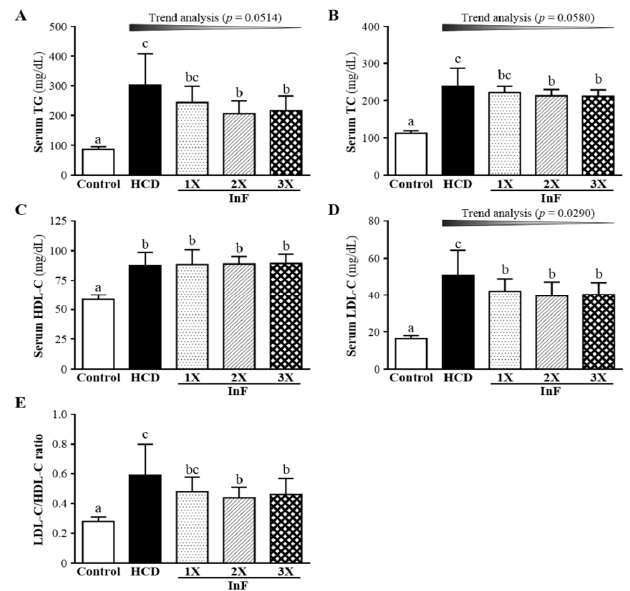
Figure 2. Effect of two-week InF supplementation on serum TG ( A ); TC ( B ); HDL-C ( C ); LDL-C ( D ) levels; and LDL-C/HDL-C ratio ( E ) in hyperlipidemic hamsters. Data are mean ± SD ( n = 8/group); values with different letters (a, b, c) differ significantly at p < 0.05 by one-way ANOVA. 2.4. Effect of Four-Week InF Supplementation on Serum Lipid Profiles in Hyperlipidemic Hamsters At 4 weeks after treatment, all lipid levels were higher with HCD alone than control treatment (Figure 3). Only HDL-C level showed no difference with InF treatment than HCD alone. For TG, TC, LDL-C and LDL-C/HDL-C ratio, levels were lower with InF treatment than HCD alone.